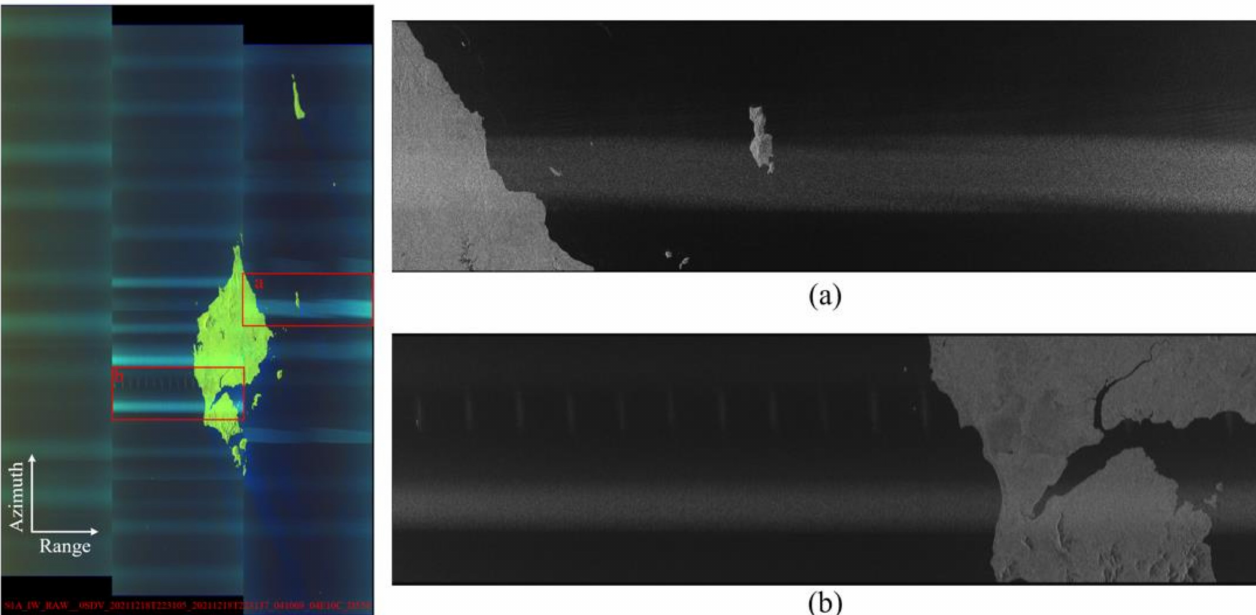
Figure 8. SAR image of the measured Sentinel-1 data. ( a ) The RFI-corrupted burst with a single source. ( b ) The RFI-corrupted burst with multiple sources.